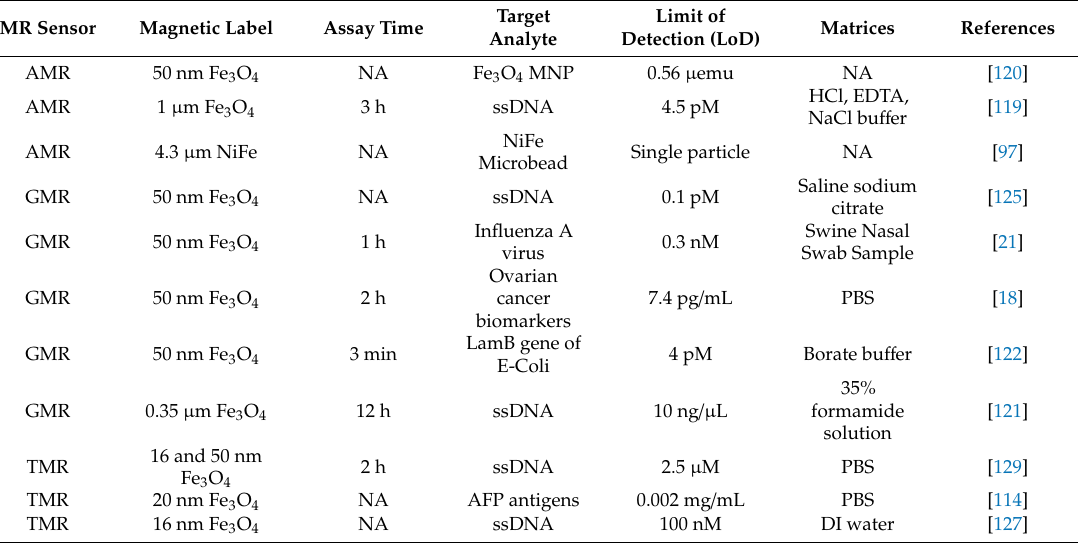
Table 1. Comparisons between di ff erent magnetoresistive